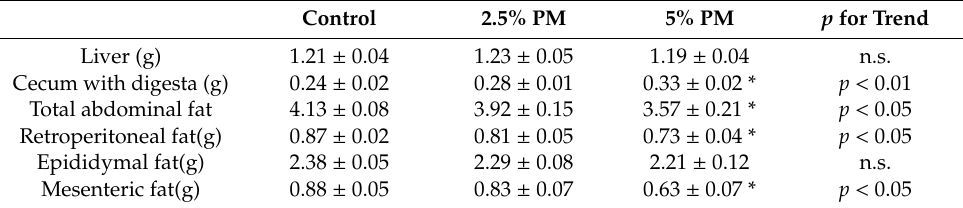
Table 4. Weight of organs.